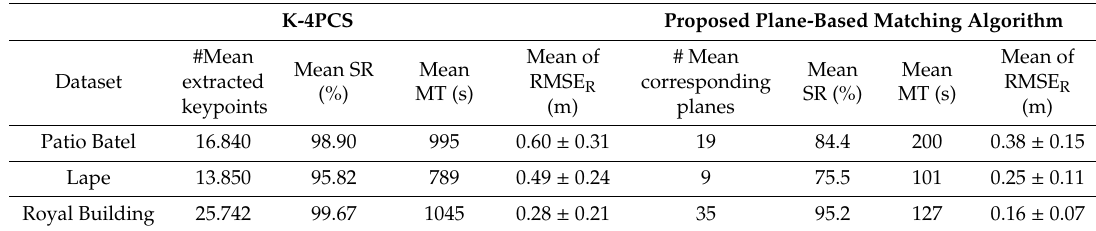
Table 2. Evaluation of our proposed plane-based matching algorithm and K-4PCS